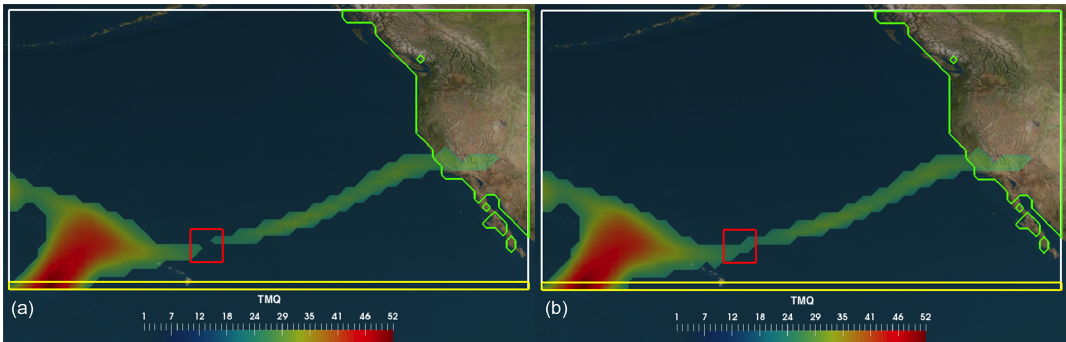
Figure 5. An illustration of finding connected AR regions over a specified search sector. In this example, the search for ARs is bounded by the latitude of the Hawaiian Islands (yellow line) and the west coast of North America (green line). (a) The red box indicates the location of two regions that are disconnected at some value (IWV = t 1 ). (b) At a new value (IWV = t 2 ), where t 2 < t 1 , the two connected regions merge into one new connected region, forming a valid AR pattern. The IWV (kgm − 2 ) plotted in this example is from the CAM5.1 climate